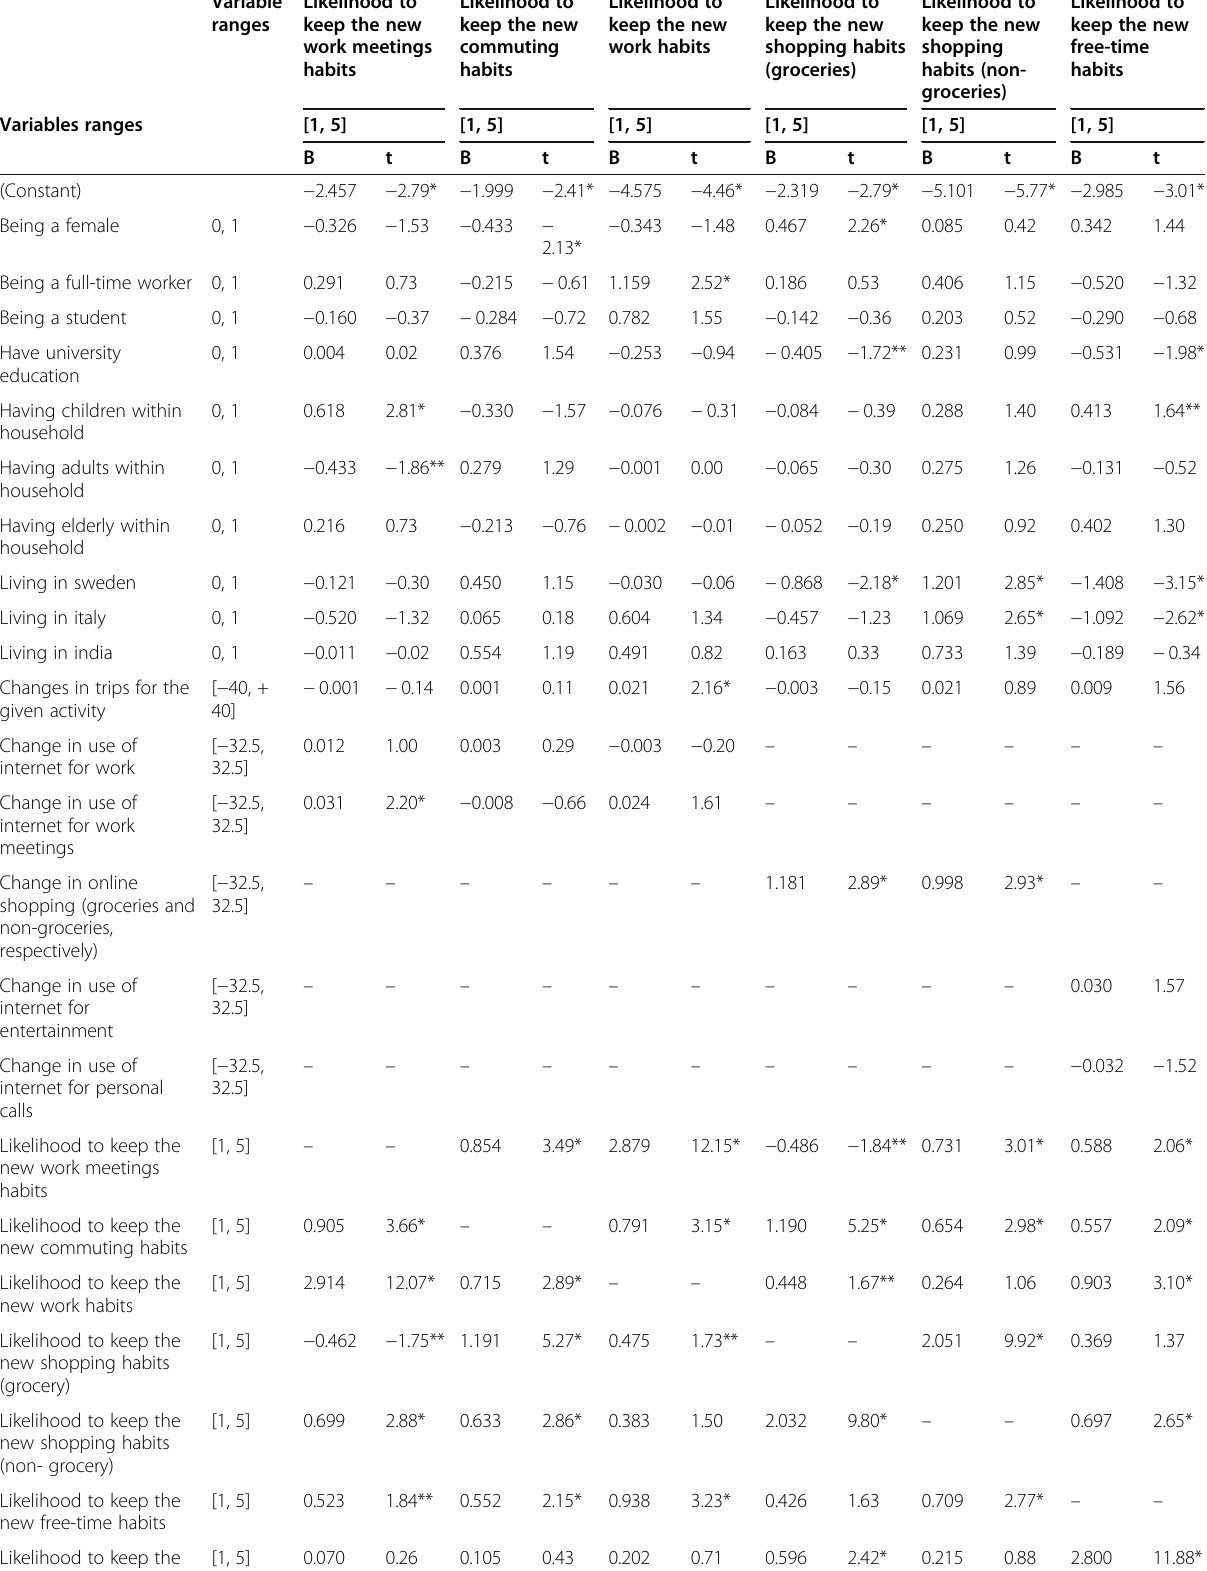
Table 4 Binary logistic regression for a likelihood of keeping the behavioural changes after the pandemic